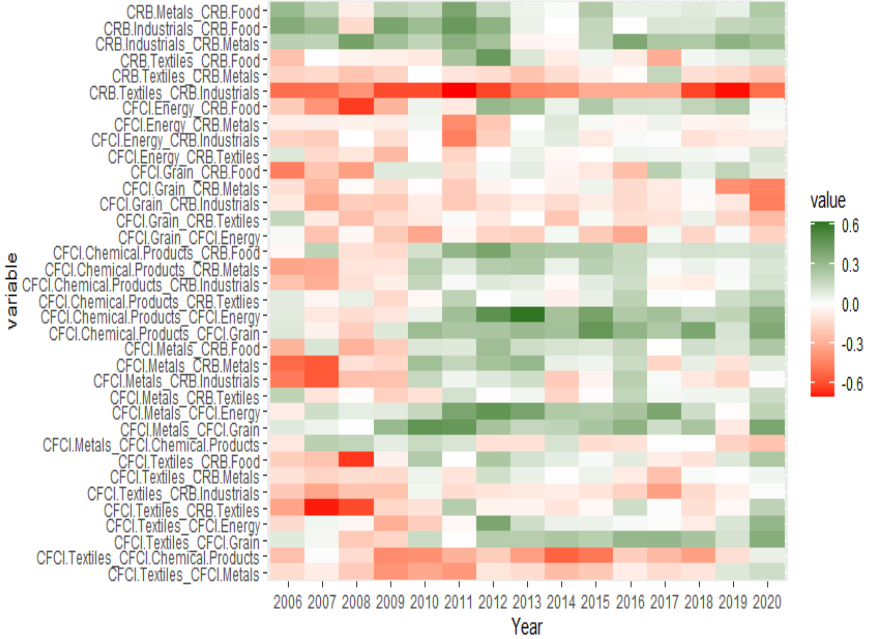
Figure 5. Thermal diagram of the directional volatility spillover between commodities. Note: Take the variable “A_B” as an example, if the color is green, A is the risk exporter while B is the risk recipient; if the color is red, B is the risk exporter and A is the risk recipient.